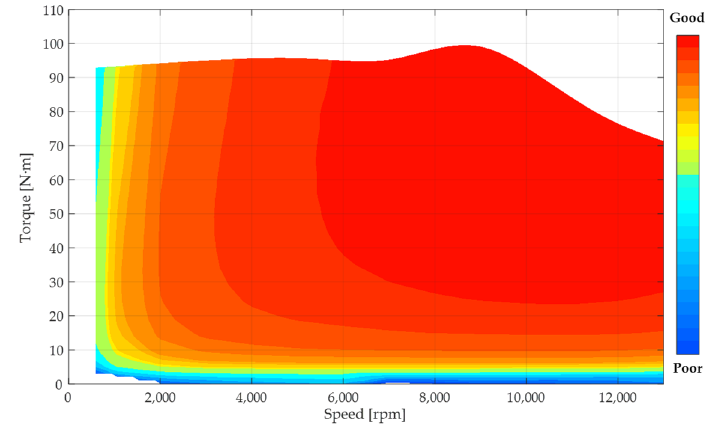
Figure 5. Engine efficiency map.